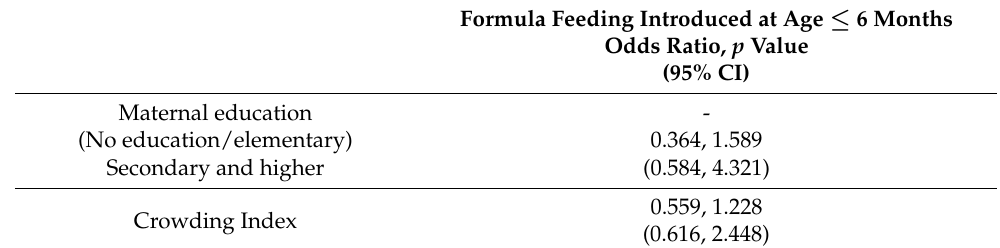
Table 1. Effect of maternal education, maternal employment and crowding index on age at introduc- tion to formula feeding by 6 months versus over 6 months. Formula Feeding Introduced at Age ≤ 6 Months Odds Ratio, p Value (95% CI) Maternal education